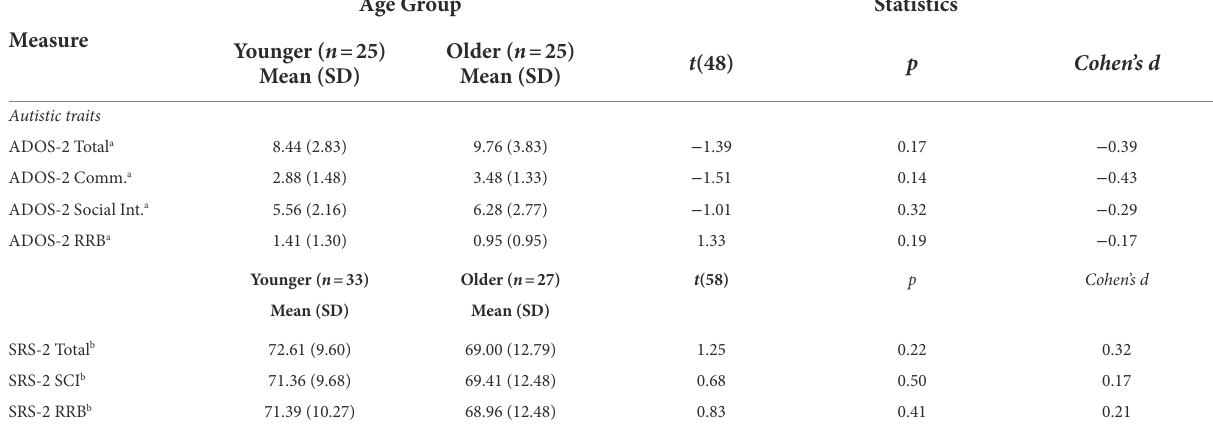
TABLE 4 T1 comparisons of autistic traits in younger and older adults.